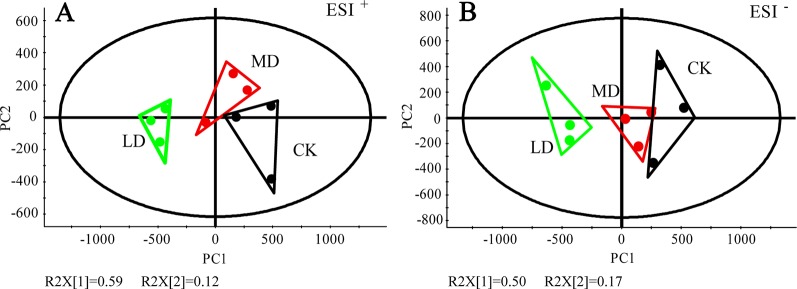
PCA analysis of tea leaves exposed to tea green leafhopper attack and mechanical damage. (A) PCA score plot for tea samples based on 2,381 molecular features detected in ESI+. (B) PCA score plot for tea samples based on 906 molecular features detected in ESI-. R2X, explained variation. PC1, the first principal component. PC2, the second principal component. For tea samples with different treatments, three biological replicates were prepared, where one replicate was a pool of collected materials from different tea plants. LD, tea green leafhopper-infested leaves; MD, mechanically damaged leaves; CK, undamaged control.